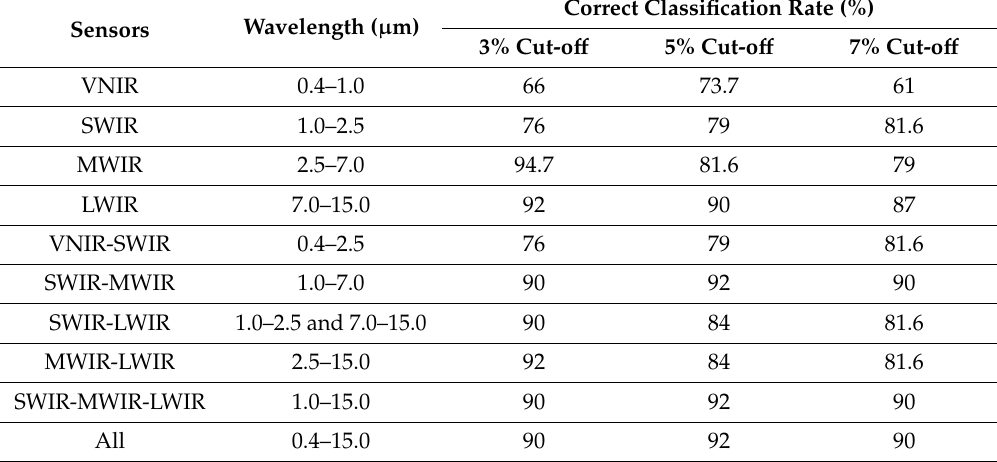
Table 4. Summary of the correct classification rates when a K-means classifier was applied to the individual and fused data blocks. The ore − waste classification rates for the three cut-o ff grades are indicated for each data model. The wavelength range indicates the operating wavelength range of the technologies.